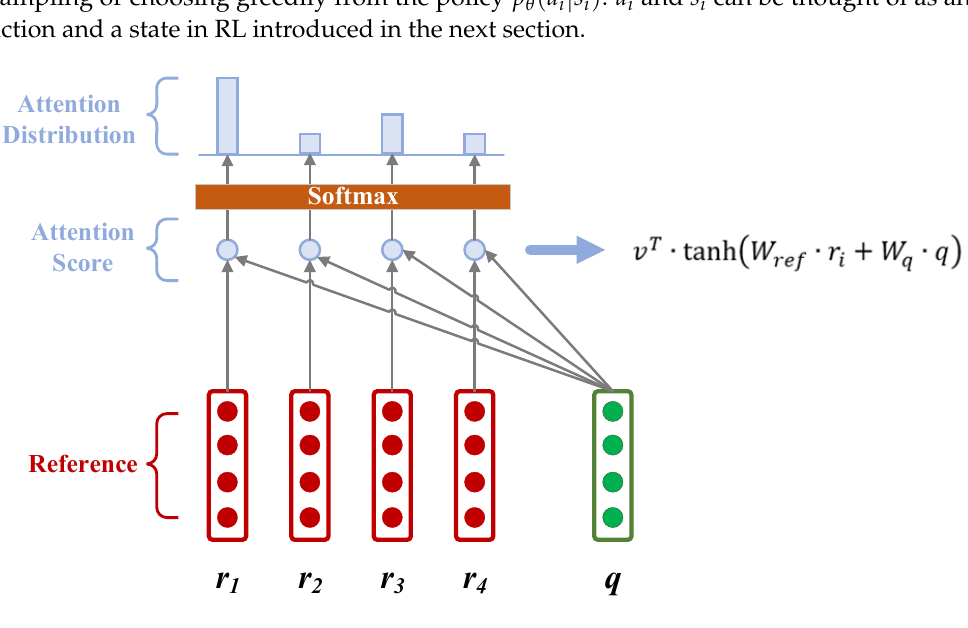
Figure 7. The calculation process of the attention mechanism.